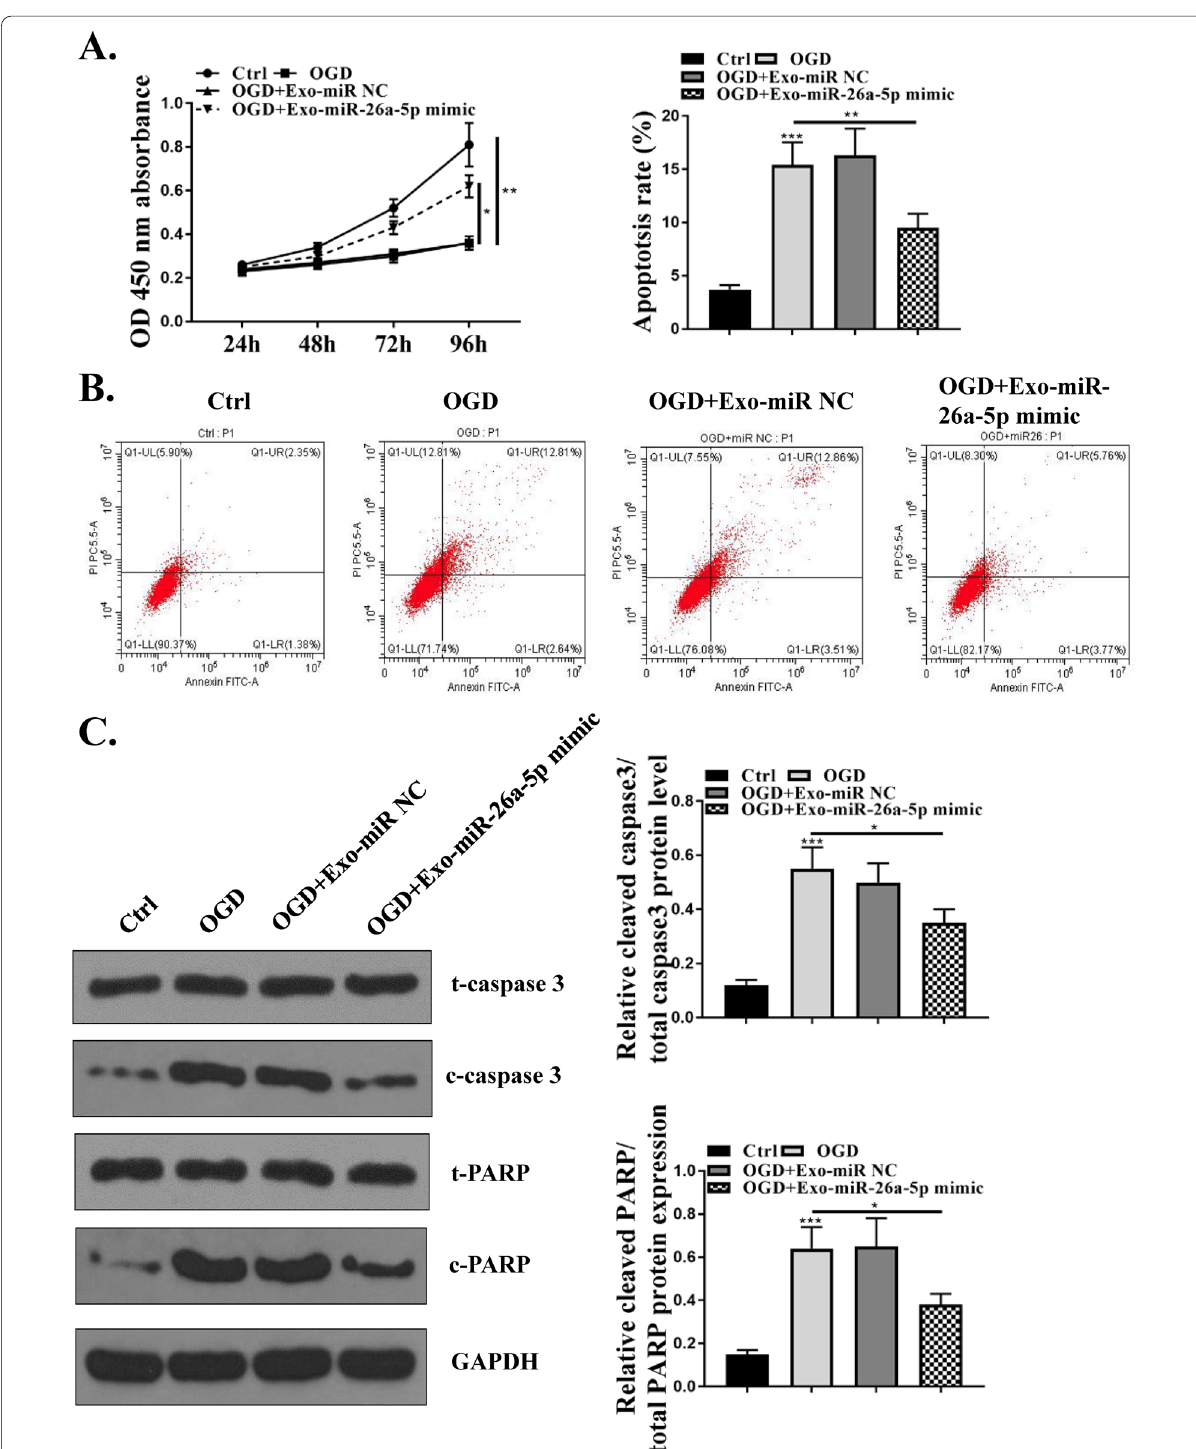
Fig. 3 miR-26a-5p reversed the effects of MSCs-derived exosomes in reducing cell apoptosis of OGD-injured microglia. BV-2 cells were treated by OGD for the given time, and then treated with 200 μg/mL Exo-miR ‐ 26a-5p mimics or Exo-miR-NC. A Cell viability was evaluated by CCK-8 assay. B Cell apoptosis was detected by flow cytometry. C The protein expression of apoptosis-related makers (cleaved caspase-3, total caspase-3, cleaved RARP and total RARP) was evaluated by western blot. *p < 0.05, **p < 0.01, ***p <